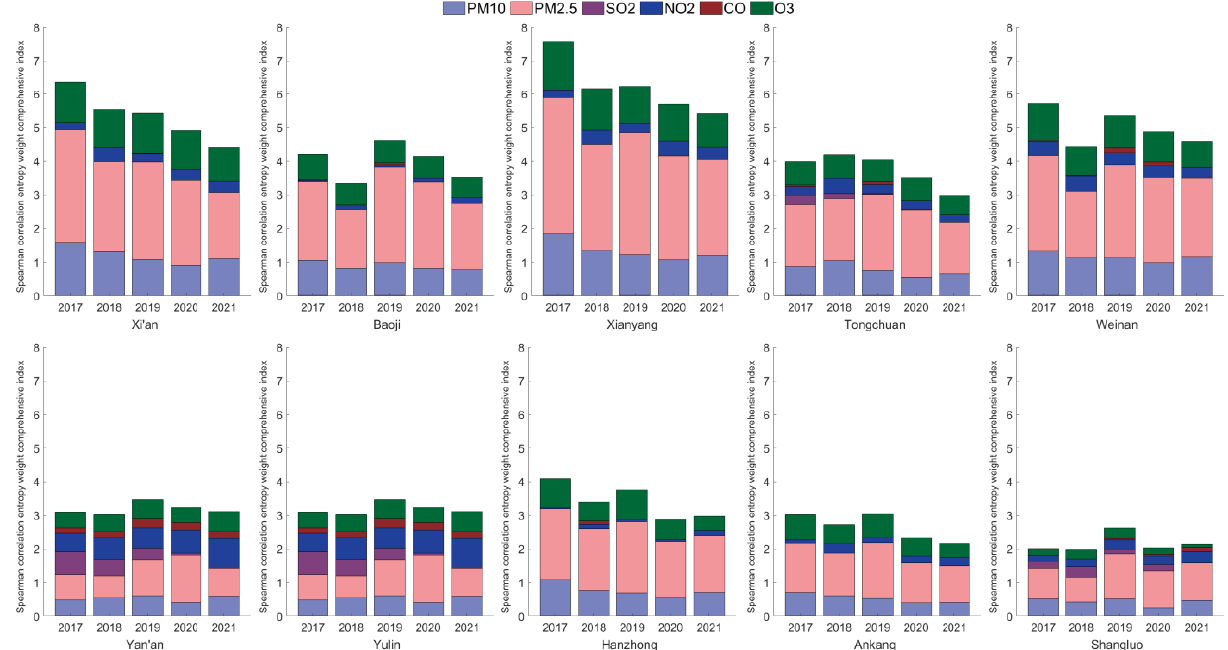
Figure 5. The comprehensive Spearman correlation entropy weight index values of the 10 cities from 2017 to 2021. 2017 to